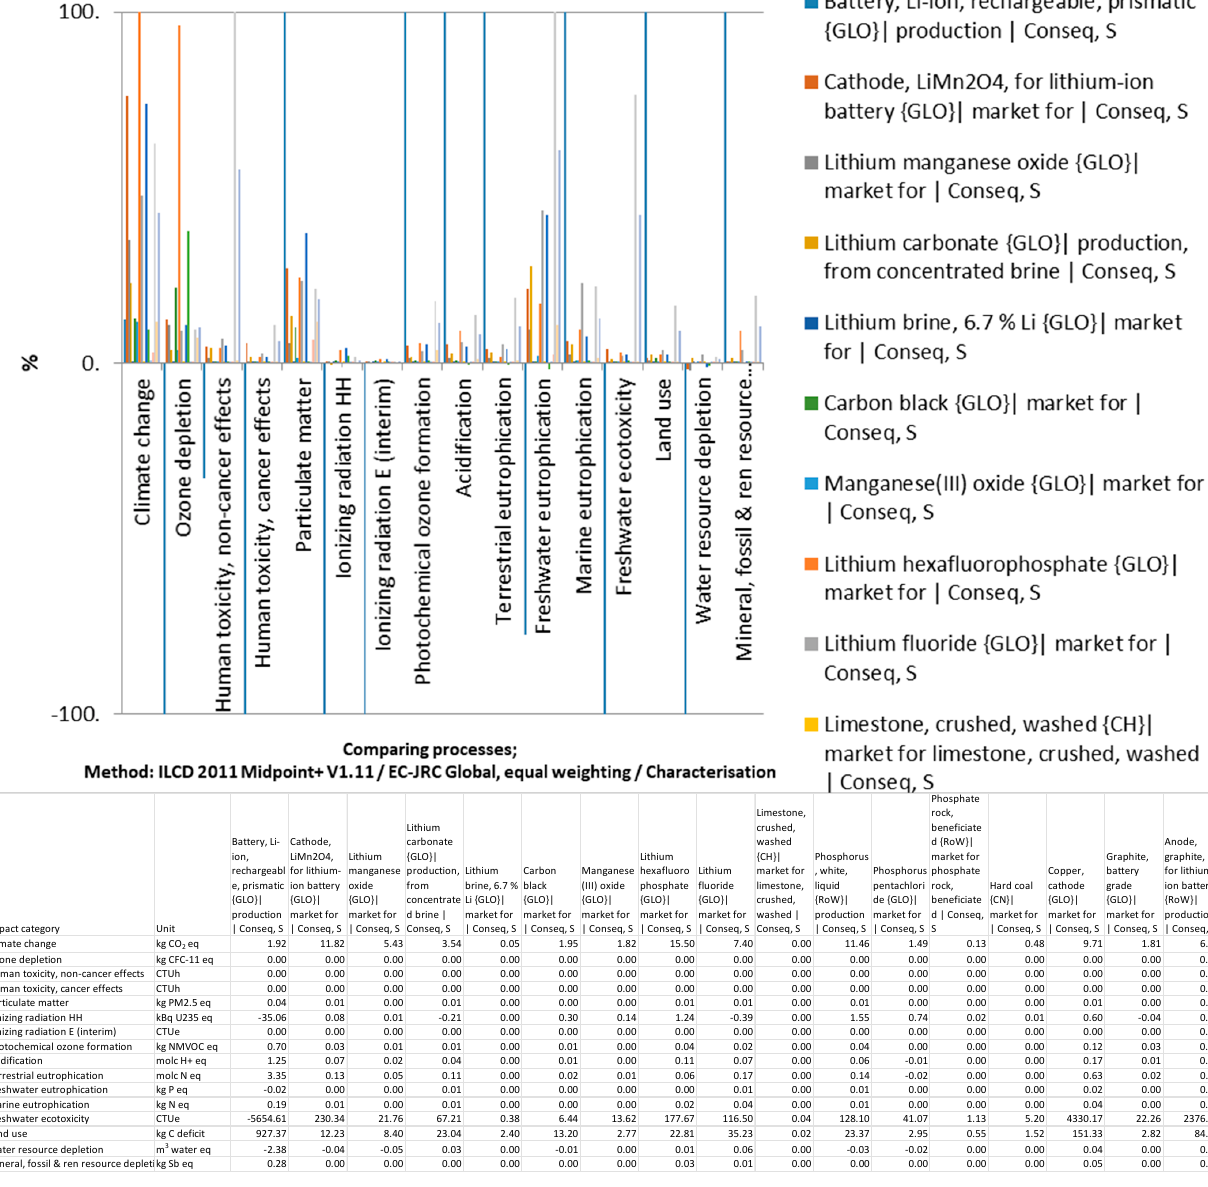
Figure 7. ILCD life cycle impact characterisations of 1 kg of each key material shown in Table 1. CTU: comparative toxic units. NMVOC: non-methane volatile organic compound.